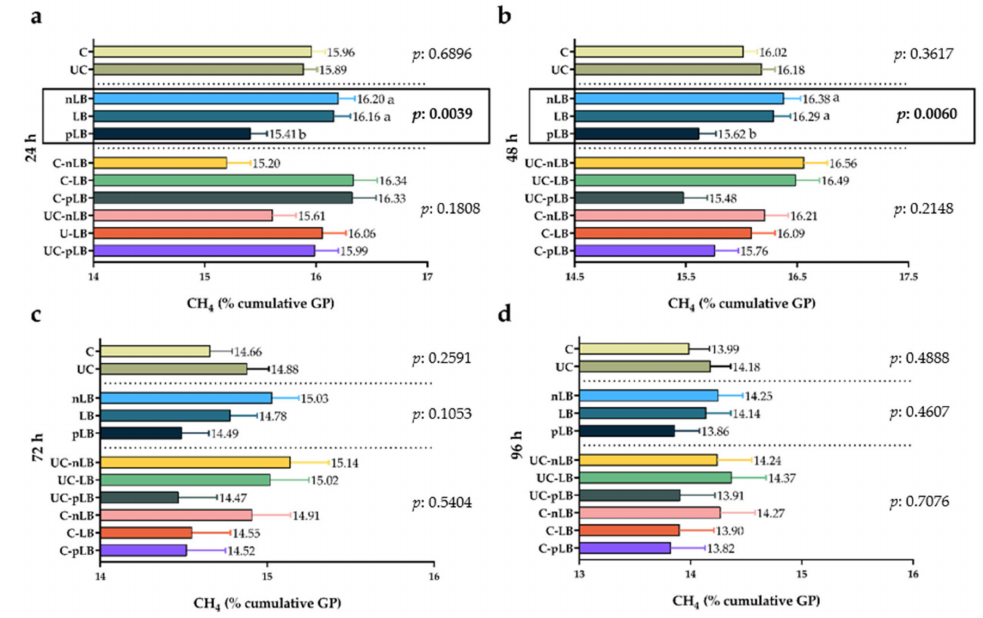
Figure 6. Effect of urea treatment and L. buchneri forms on the in vitro methane ratio of corn silage. Changes in the methane (CH 4 ) ratio of corn silage after 24 h ( a ), 48 h ( b ), 72 h ( c ), and 96 h ( d ). A dotted line separates the urea treatment, the L. buchneri forms, and their interaction. C: corn silages not treated with urea, UC: corn silages treated with 1.0% urea on dry matter basis, C-nLB: corn silages not treated with urea and uninoculated with L. buchneri , C-LB: corn silages not treated with urea and inoculated with L. buchneri , C-pLB: corn silages not treated with urea and inoculated with preactivated L. buchneri , UC-nLB: corn silages treated with urea and uninoculated with L. buchneri , UC-LB: corn silages treated with urea and inoculated with L. buchneri , UC-pLB: corn silages treated with urea and inoculated with preactivated L. buchneri , CH 4 : methane, GP: gas production. Factors that are statistically significant are highlighted in bold ( p < 0.05). Values with different letters (a–c) in each graph are statistically different ( p <